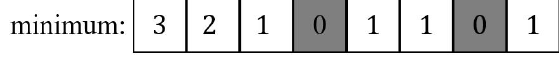
Figure 5. An Example of Step 1.2.